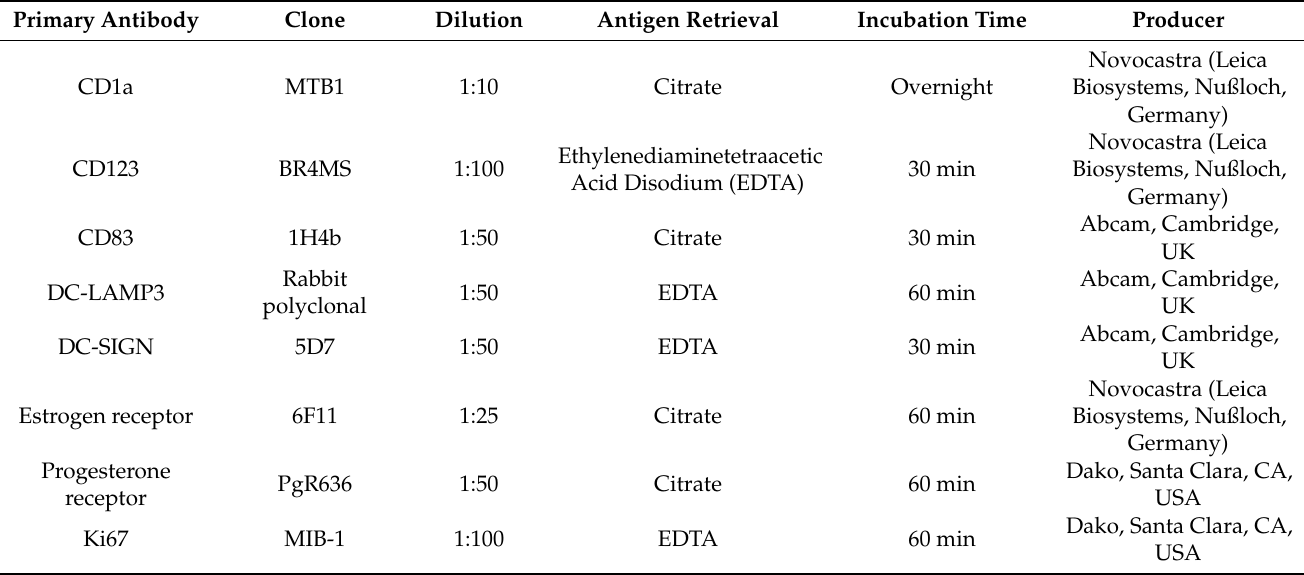
Table 1. Antibodies used in the study.